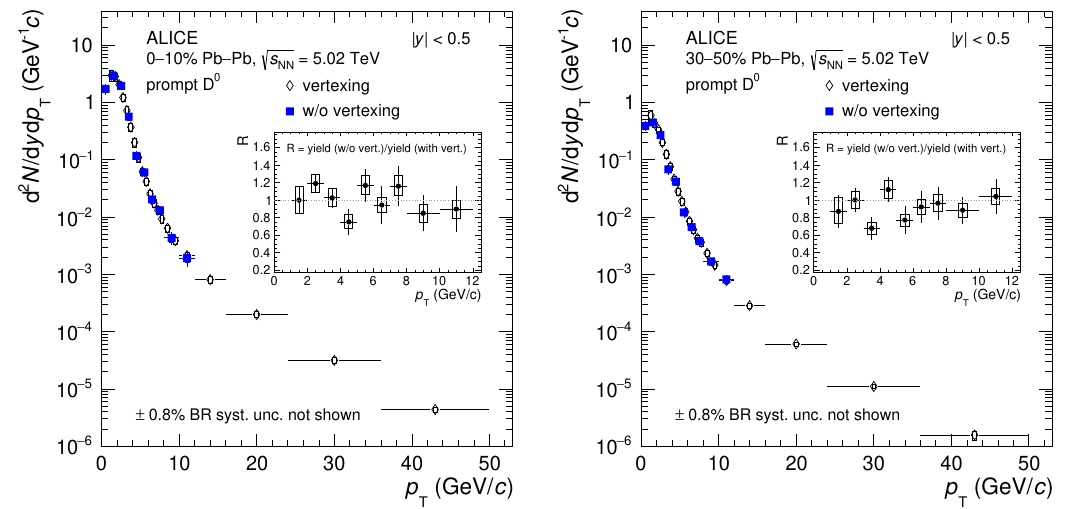
Figure 3 . Transverse momentum distributions d 2 N/ d y d p T of prompt D 0 mesons from the analysis with (open marker) and without (full marker) decay-vertex reconstruction in the 0–10% and 30– 50% centrality classes in Pb–Pb collisions at systematic uncertainties (boxes) are